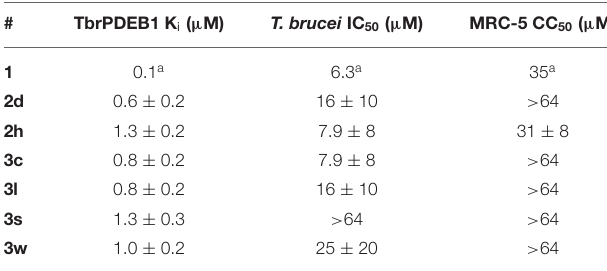
TABLE 3 | In vitro activity of selected phthalazinones against TbrPDEB1, T. brucei parasites, and MRC-5